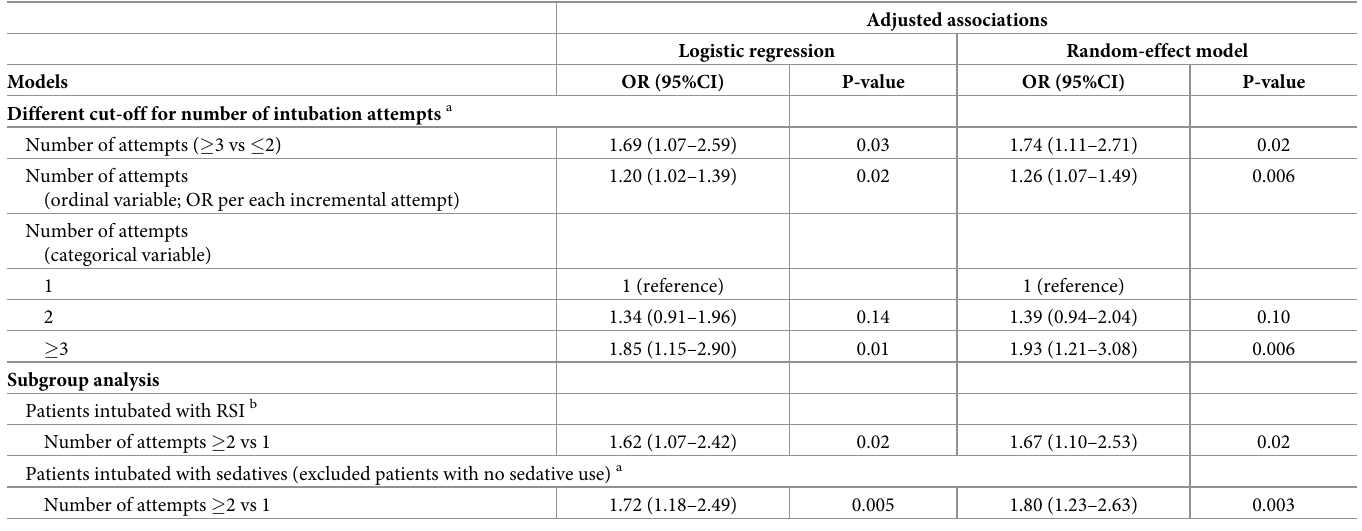
Table 4. Sensitivity analysis using different cut-off for number of intubation attempts and different